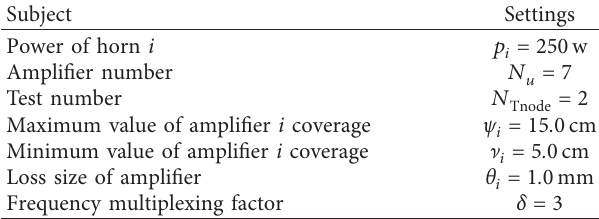
Table 2: Simulation parameters of ultrasonic vibration network.